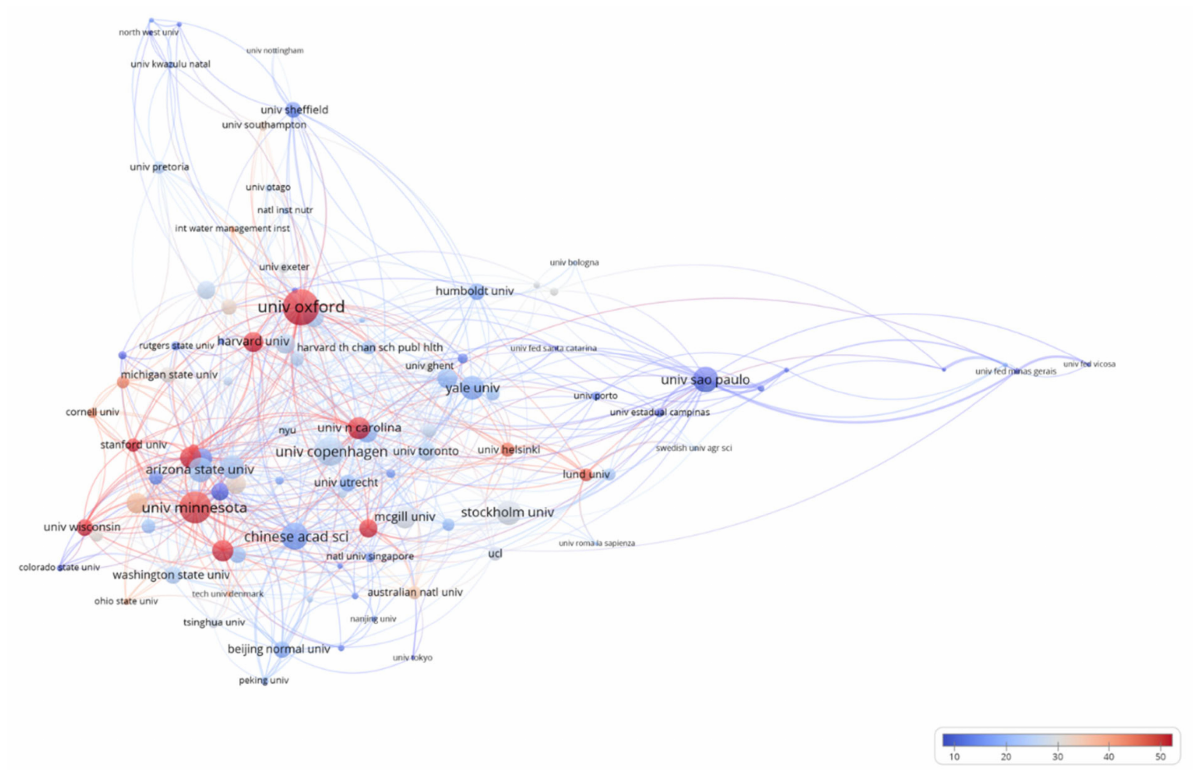
Figure 5. Co-occurrences of the